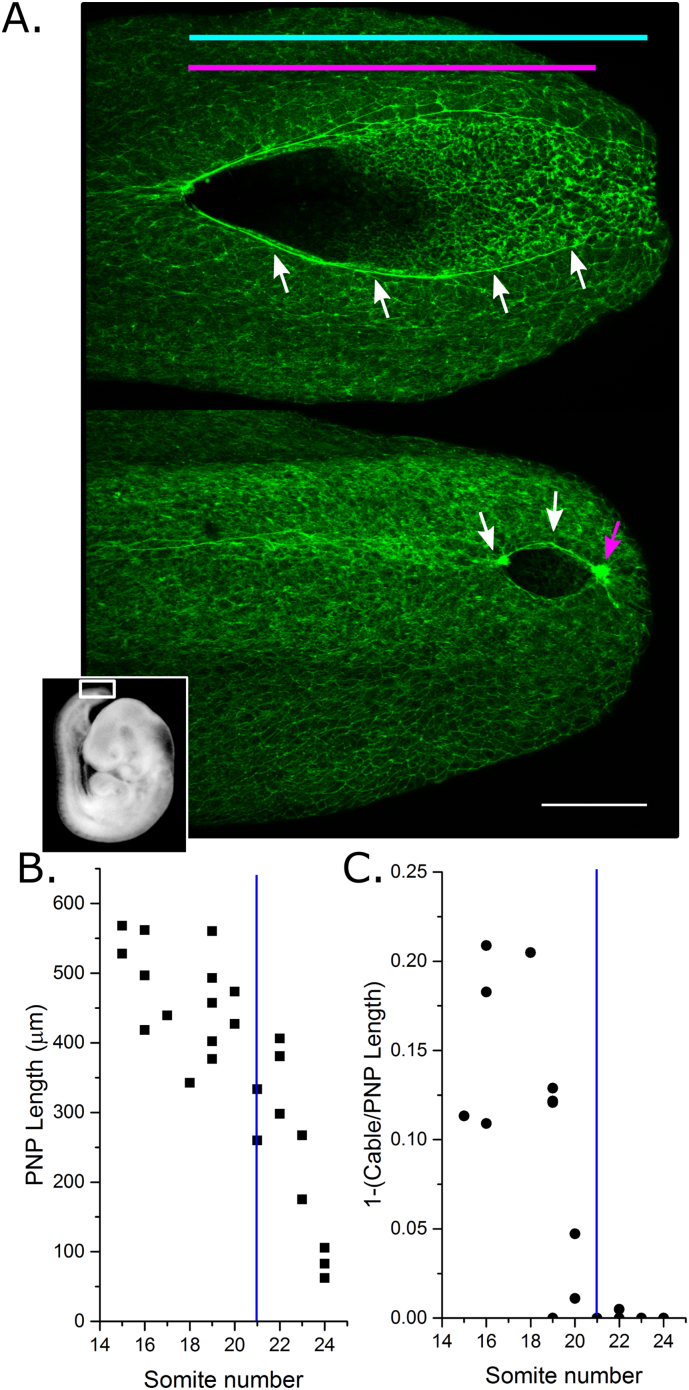
Closure 5 forms when completion of PNP closure is imminent in CD1 mouse embryos. A) Representative dorso-ventral views of whole mount phalloidin-stained PNPs at mid (top) and late (bottom) spinal neurulation stages. The white box in the embryo inset image indicates the location of the PNP. White arrows indicate the F-actin cable along the neural folds. The magenta arrow indicates the position of Closure 5. PNP length (cyan line) and F-actin cable linear length (magenta line) were calculated. Scale bar = 100 μm. B) PNP length decreases with advancing somite stage, with completion of closure occurring ~ 25 somites in CD1 embryos used in this study. C) The proportion of the PNP not encompassed by the F-actin cable decreases until the cable encircles the PNP at ~ 21 somites in CD1 embryos. Vertical blue lines = 21 somites.